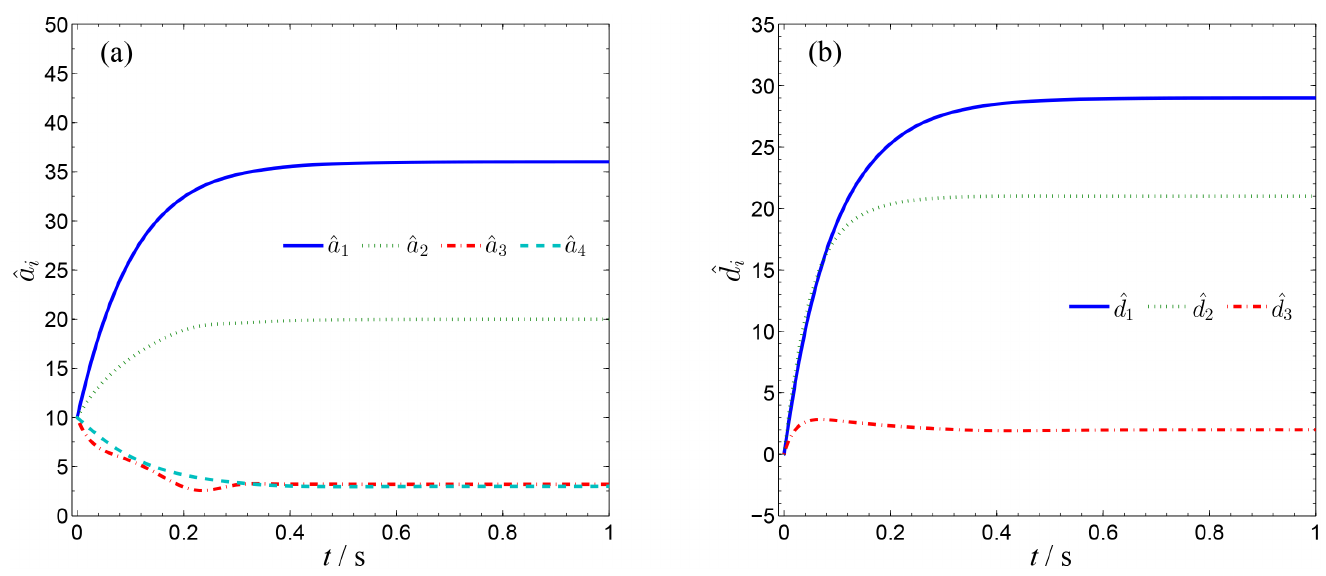
Fig 13. Identification of unknown parameters of systems (12) and (25). (a) ^ a 1 ; ^ a 2 ; ^ a 3 ; ^ a 4 ; (b) ^ d 1 ; ^ d 2 ; ^ d 3 ; ^ d 4